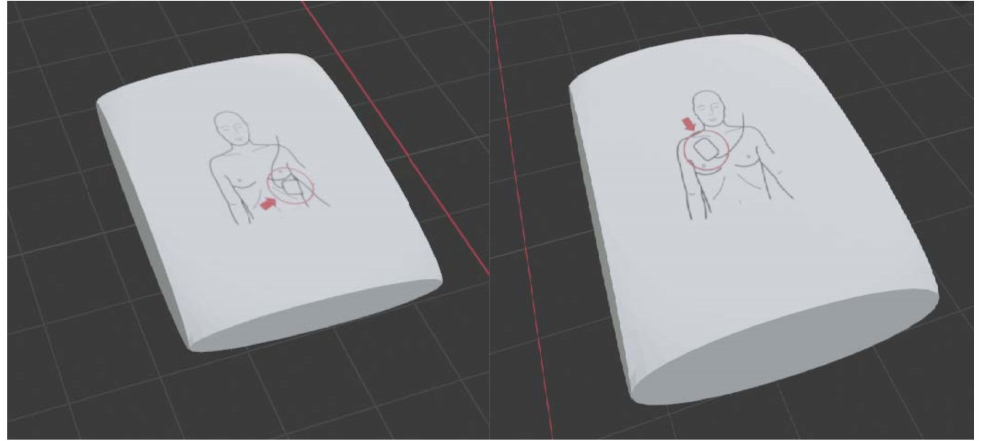
Figure 3. Early Blender creations of shock pads. The circle and arrow in the image provide extra guidance for shock pad